Question: Compose a caption that would accompany this figure in a paper.
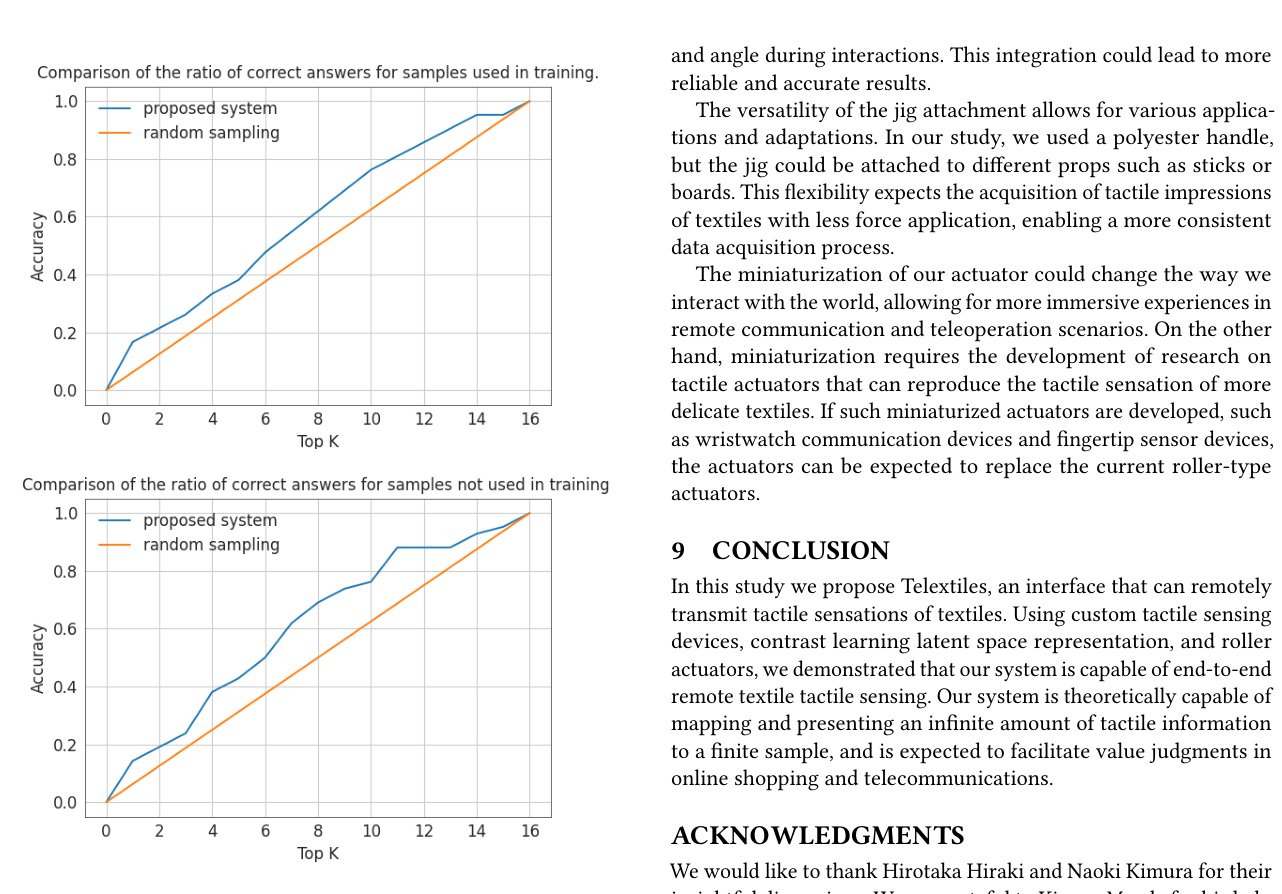
Answer: Comparison of human judgment and model infer- ence in identifying the closest tactile match among 16 textiles for a randomly selected cloth sample, for samples used in training and samples not used in training. The graph presents the percentage of correct responses when the human-selected textile is within the Top K model-inferred closest textiles, compared to the expected correct answer rate from random textile choice.